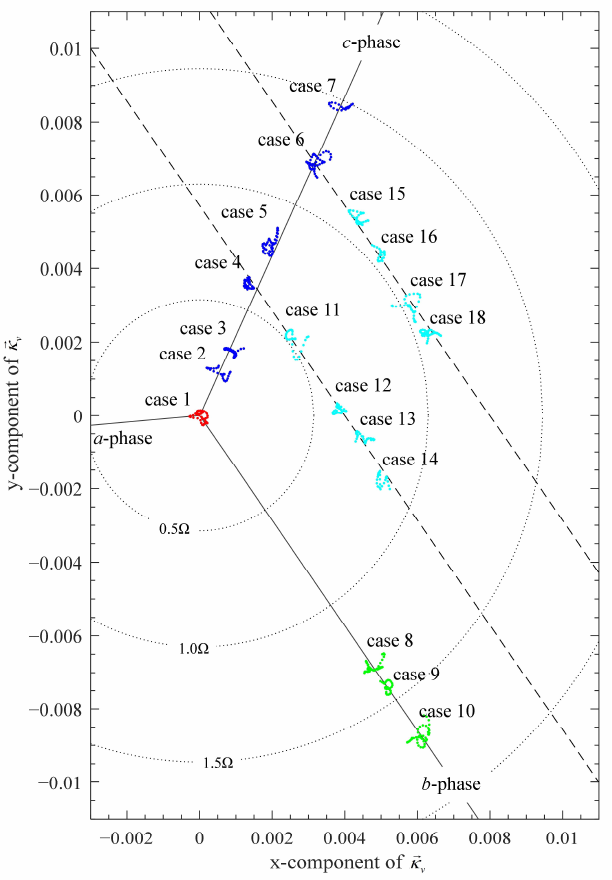
Figure 7. The plane plotting the fault condition of HRC under cases 1–18.